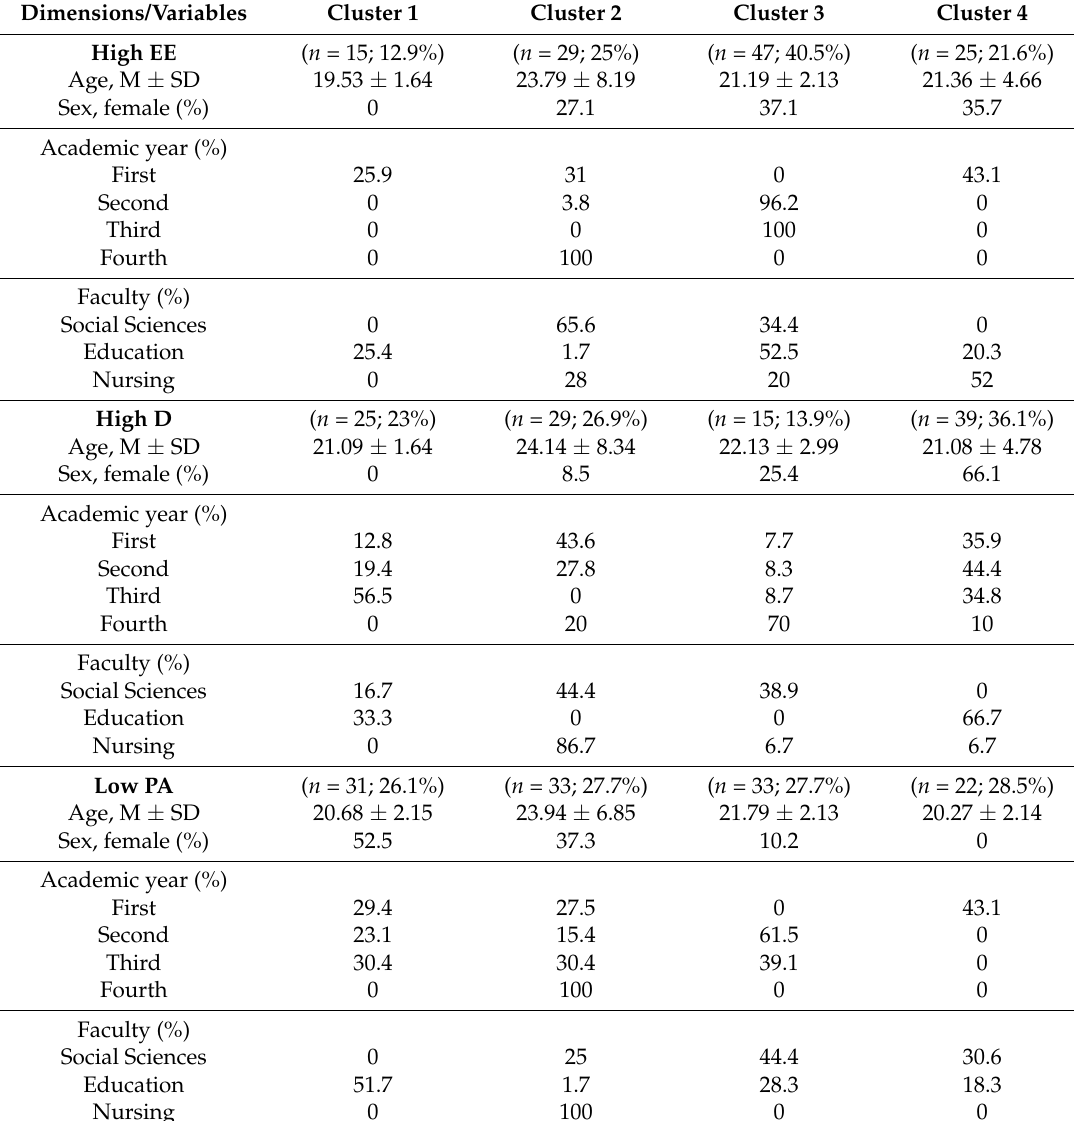
Table 2. Cluster analysis profile in students with high levels of